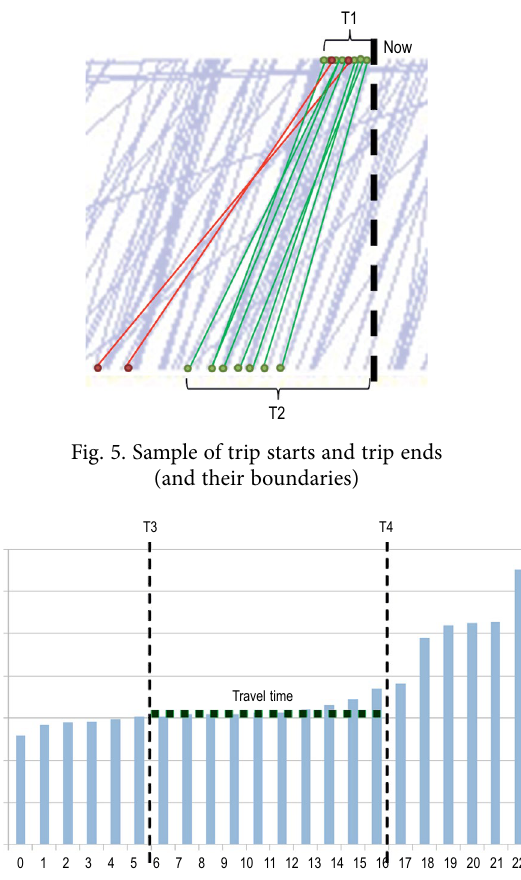
Fig. 6. Sample of valid travel times and their trimmed average